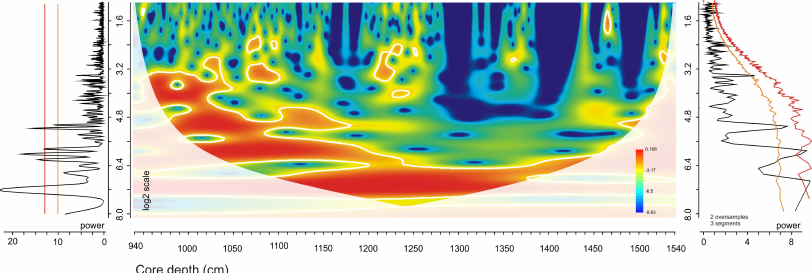
Fig. 4. Morlet wavelet power spectrum based on the 3point-running mean data set (white line indicates significance level, p = 0.05). The Lomb–Scargle (left) and the REDFIT (right) periodograms illustrated previously in Fig. 3 are now drawn along a log2-scale (vertical axis) for easier comparison of frequency peaks in the power spectra in Fig. 3 with those in the wavelet spectrum (orange and red lines represent 95 and 99% confidence intervals). The colour scale represents the strength (i.e. power) of the signal in the wavelet spectrum – red for the high, blue for the low power. Horizontal scale of the wavelet analysis plot represents the core depth in centimetres.